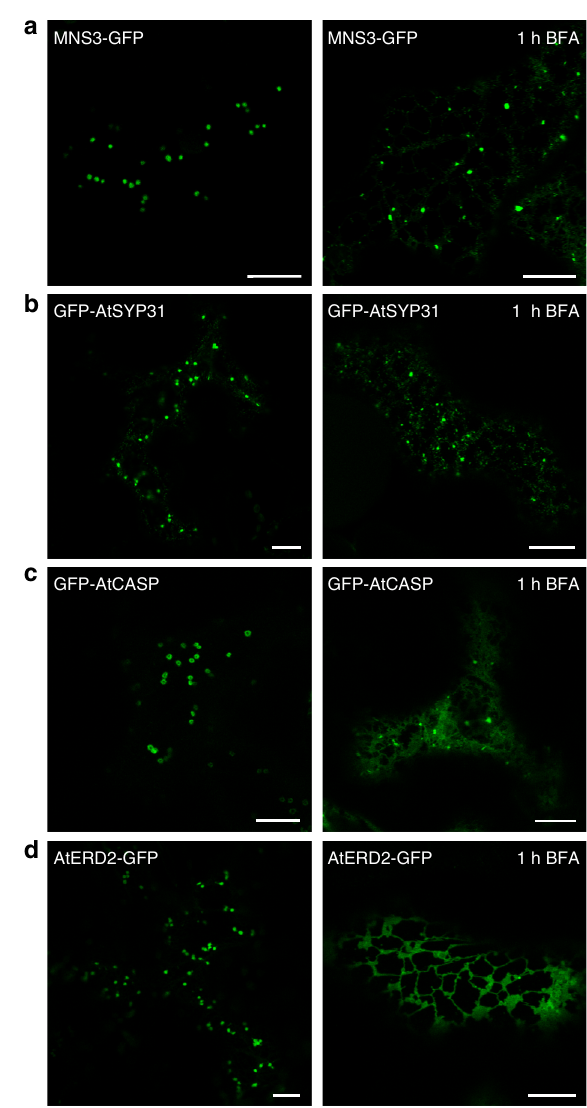
Fig. 3 MNS3 largely remains on punctate structures during Golgi disassembly. Fusion proteins were transiently expressed in N . benthamiana leaf epidermal cells and observed 2 – 3 dpi using confocal microscopy. a Confocal images showing the subcellular localization of MNS3-GFP before (0 h BFA) and after BFA addition (2 h BFA). Scale bars = 20 µ m. b A representative cell that co-expresses MNS3-GFP (green) with STtmd- mRFP (magenta) and was treated with BFA for 2 h (upper panel) or additionally expresses GTP-locked SAR1 (SAR1-GTP, lower panel). Scale bars = 10 µ m. c A representative cell that co-expresses MNS3-GFP (green) with the cis -Golgi golgin mRFP-AtCASP (magenta) and was treated with BFA for 2 h (upper panel) or additionally expresses SAR1-GTP (lower panel). Scale bars = 10 µ after BFA removal by receiving Golgi material from the ER 40,41 . To compare the BFA-induced localization pattern of MNS3 with that of AtSYP31, we expressed MNS3-GFP and GFP-AtSYP31, respectively, in N . benthamiana leaves and observed their response to BFA via confocal microscopy. Before BFA addition, both fusion proteins exclusively concentrated on Golgi stacks (Fig. 4a, b). One hour after BFA addition, MNS3-GFP and GFP- AtSYP31 highlighted a dispersed pattern of puncta that did not change after longer BFA incubation times. The BFA treatment of cells co-expressing GFP-AtSYP31 and MNS3-mRFP showed a co-